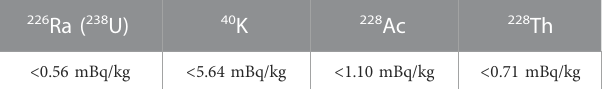
TABLE 2 Representative HPGe result of puri fi ed powder from raw powder puri fi cation. The upper limits are given at 90% C.L. 226 Ra ( 238 U) 40 K < 0.56